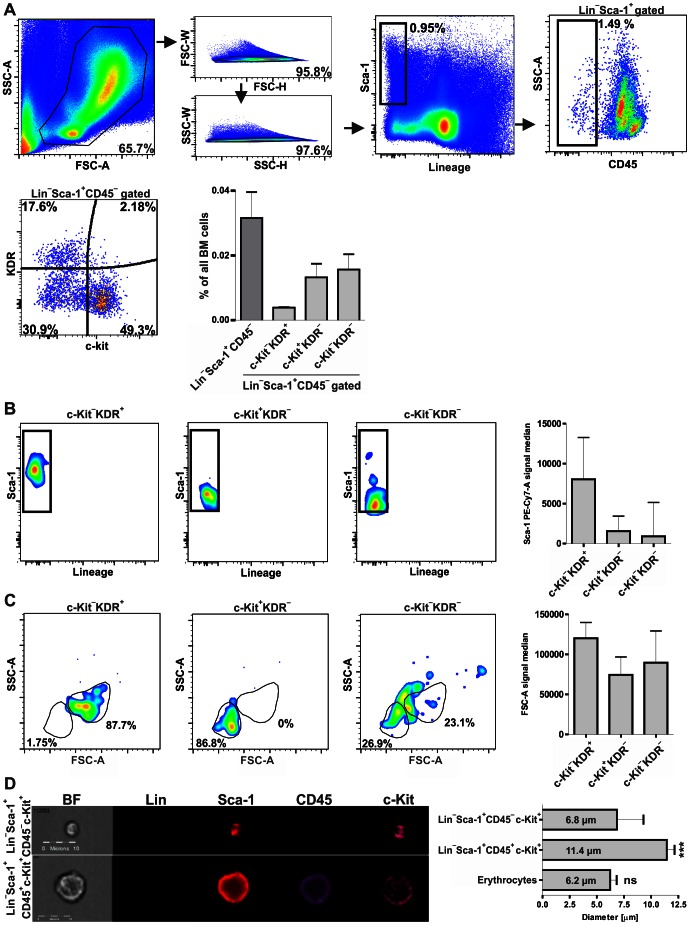
Heterogeneity of BM-derived Lin−Sca-1+CD45− population.(A) c-Kit−KDR+, c-Kit+KDR− and −c-Kit−KDR− subsets could be distinguished within Lin−Sca-1+CD45− population. (B) c-Kit−KDR+ subpopulation showed higher Sca-1 expression comparing to c-Kit+KDR− and c-Kit−KDR− subpopulations. (C) c-Kit+KDR− subset showed the most restricted FSClow phenotype. c-Kit−KDR− subpopulation also included FSClow cells, while no such cells were visible in c-Kit−KDR+ subset. (D) ImageStream analysis of non-fixed cells revealed that diameter of the Lin−Sca-1+CD45−c-Kit+ cells is significantly lower than diameter of Lin−Sca-1+CD45+c-Kit+ cells and comparable to erythrocyte size. Each bar represents mean ± SD. *** - p<0.001 vs. Lin−Sca-1+CD45−c-Kit+.